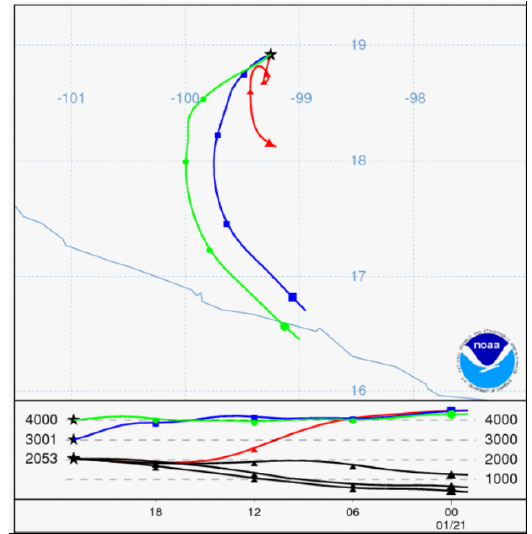
Figure 1. Behavior of wind trajectories in Cuernavaca during January and February